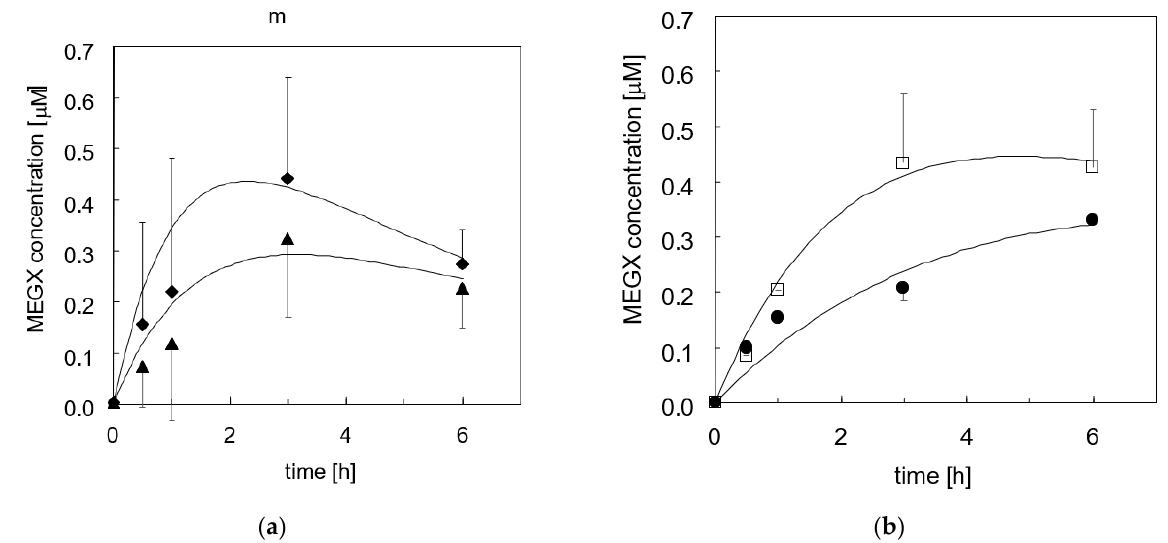
Figure 6. MEGX concentration profile in time during the kinetic tests ( n = 3) with adherent cells at various days of culture: ( a ) — ( ◆ ) day 2; ( ▲ ) day 3; ( b ) — ( ) day 4; ( ⚫ ) day 5. Lines are model predictions.